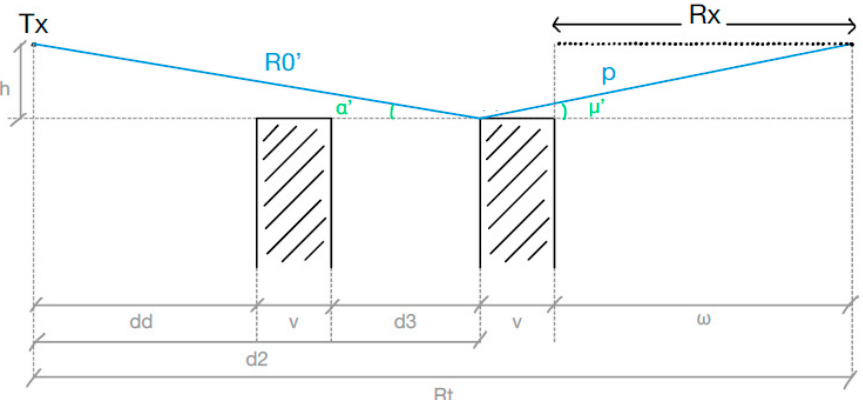
Figure 4. Second single diffraction (Edif2) of the considered LOS scenario.